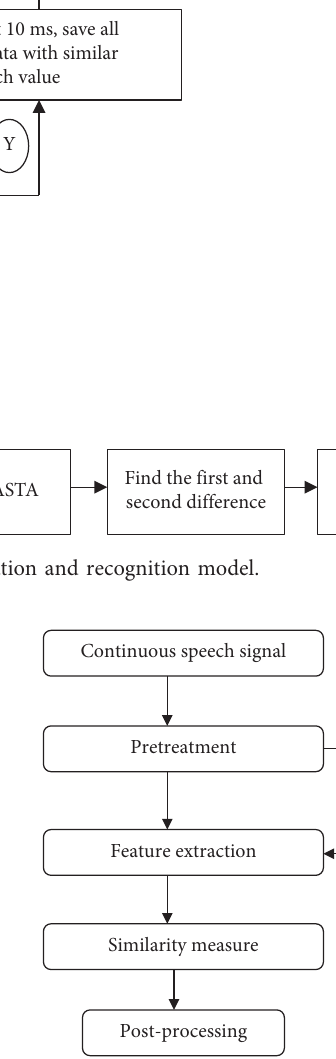
Figure 2: The basic principle of piano music recognition.